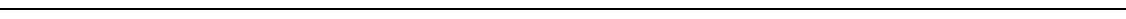
Fig. 8 Everolimus induces cell cycle arrest in AML tumour allografts. a Sulforhodamine B cell number assay of total populations of Cdkn2a Δ / Δ